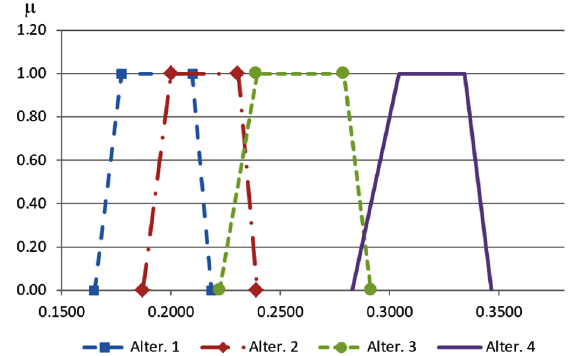
Fig. 4. Global priorities of alternatives presented as trapezoidal fuzzy numbers